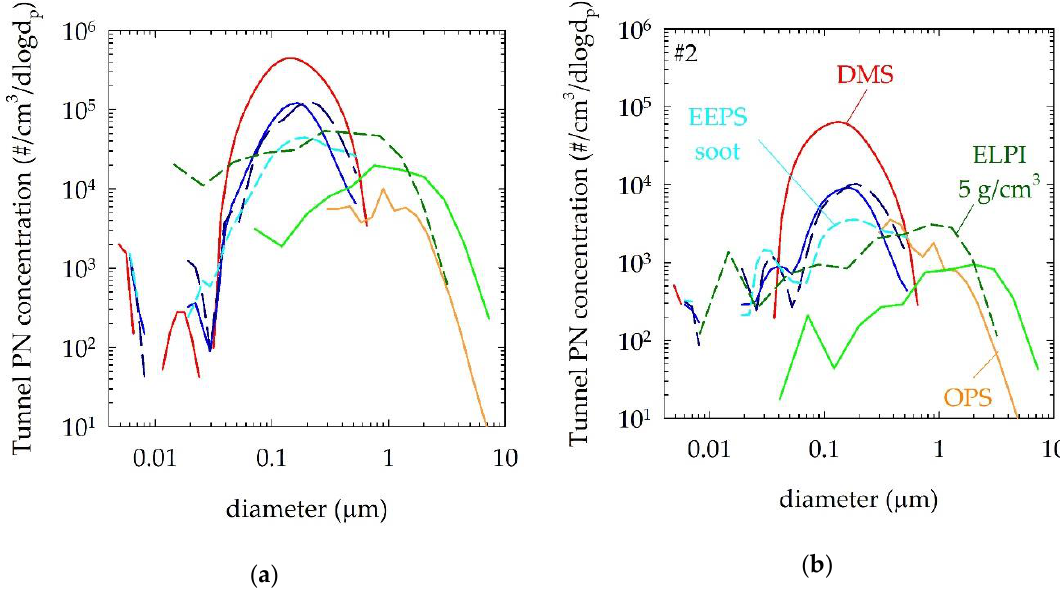
Figure 7. ( a ) Comparison of the EEPS, DMS, OPS and ELPI size distributions during the largest emission event (braking from 105 km/h—section #1 in Figure 6b) over the WLTP test with ECE#1 pad. ELPI results were calculated for constant effective densities of 1 and 5 g/cm 3 thus allowing direct comparison with the mobility size distributions of EEPS and DMS. EEPS distribution were calculated using all available inversion matrices (default, compact particles and soot particles); ( b ) corresponding size distributions over a moderate braking event (braking from 60 km/h—section #2 in Figure 6b).